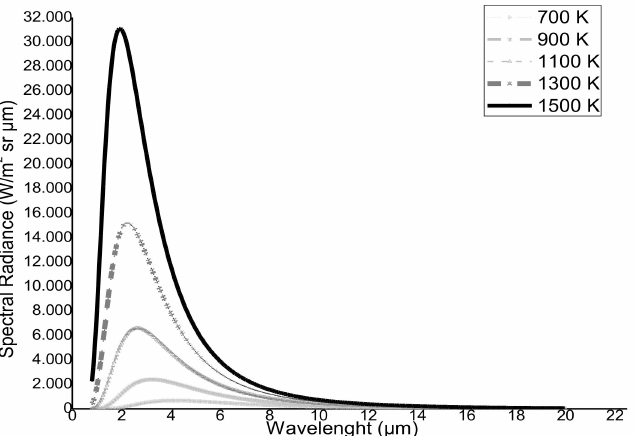
Figure 2. Planck curves for blackbodies at different magmatic temperatures (700–1500